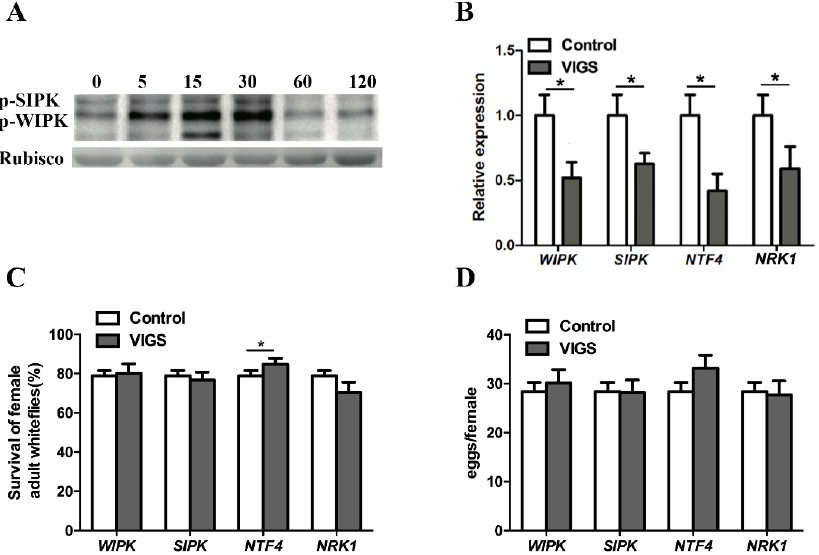
Figure 5. Effect of wound-induced protein kinase ( WIPK ), salicylic acid-induced protein kinase ( SIPK ), NTF4 , and NRK1 VIGS on the performance of whiteflies. ( A ) Whitefly feeding activated SIPK and WIPK. About 1000 whiteflies were released onto each plant, and samples were collected at 0, 5, 15, 30, 60, 120 min. Activated SIPK and WIPK were tested using Western blot with an anti-pTEpY antibody. ( B ) The expression levels of WIPK , SIPK , NTF4 , and NRK1 in gene-silenced tobacco plants and controls. ( C ) Survival rate of whiteflies on WIPK -, SIPK -, NTF4 -, and NRK1 -VIGS plants and controls. ( D ) The fecundity of whiteflies on WIPK -, SIPK -, NTF4 -, and NRK1 -VIGS plants and controls. As NTF4-1 and NTF4-2 have 98% sequence similarities, we used a common region for silencing and qPCR of these two genes. NTF4 represents NTF4-1 and NTF4-2 . The two gene expression levels of control and VIGS in each of the four combinations in ( B ) were analyzed using Student’s t test at a significance of * p < 0.05; the percentages of whitefly survival ( C ) and the mean numbers of eggs laid per female ( D ) among the four control and VIGSs were analyzed using one-way ANOVA at a significance of * p < 0.05.